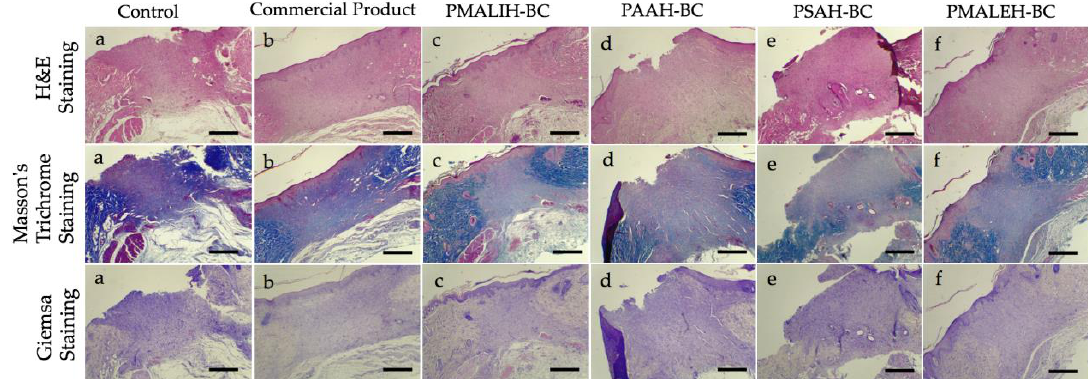
Figure 6. Histological images of H&E, Masson’s trichrome and GIEMSA stained sections after 14 days of wound healing for each sample from “a” to “f” respectively. Control: PDCAH ( a ); Commercial Product: Madecassol ® ( b ); PMALIH-BC ( c ); PAAH-BC ( d ); PSAH-BC ( e ) and PMALEH-BC ( f ). Scale bars is 100 μm.